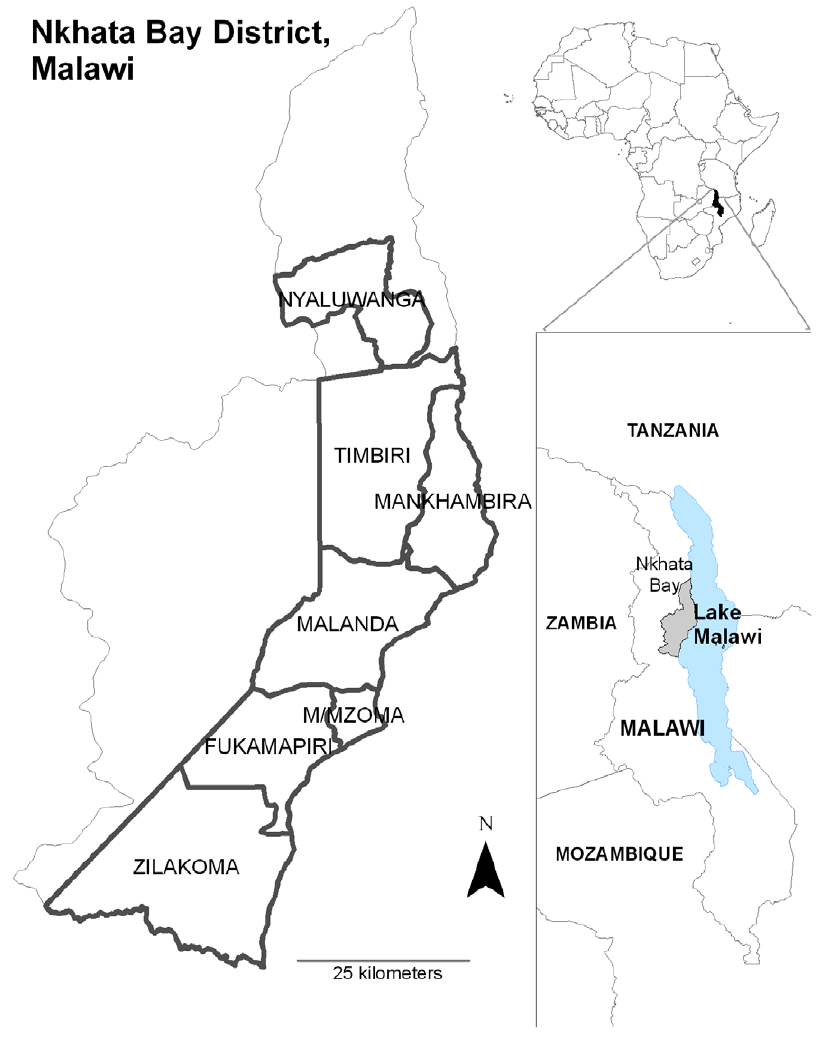
Figure 1. Household interviews were conducted to catalog the consequential lightning strikes in seven Traditional Authorities (TAs) of Nkhata Bay District, fringing the western shore of Lake Malawi. TA boundaries correspond to the period of 2008; Mankhambira TA shown here overlaps the urban TA of Mkumbira (not pictured), which comprises Nkhata Bay Town but was not surveyed. During sampling, Fukamalaza was combined with Malanda TA.